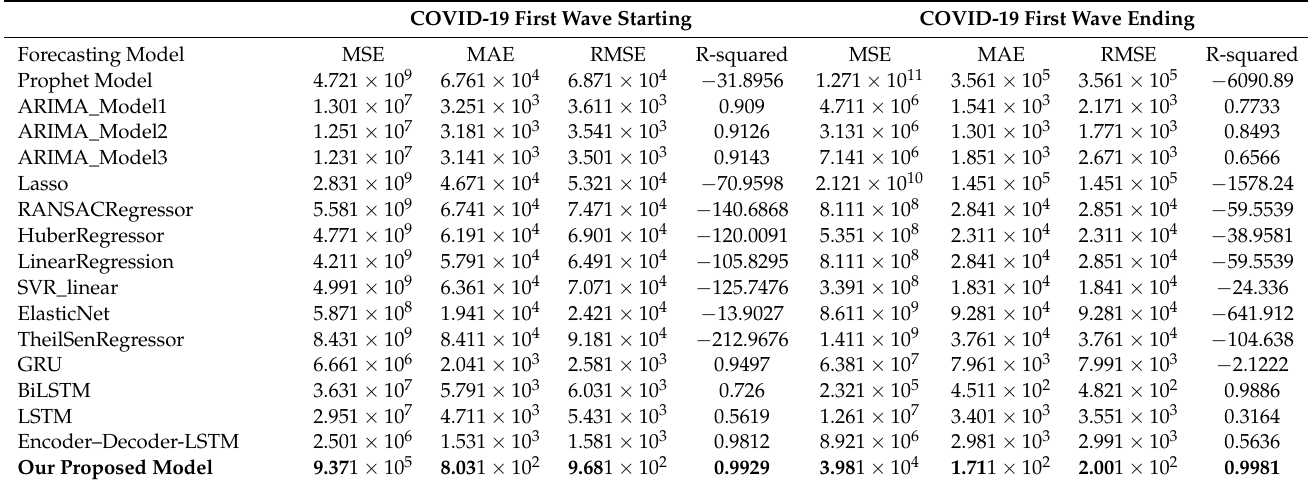
Table 1. A comparative analysis of our proposed approach with the previous methods based on statistical evaluation criteria for confirmed cases in Saudi Arabia.